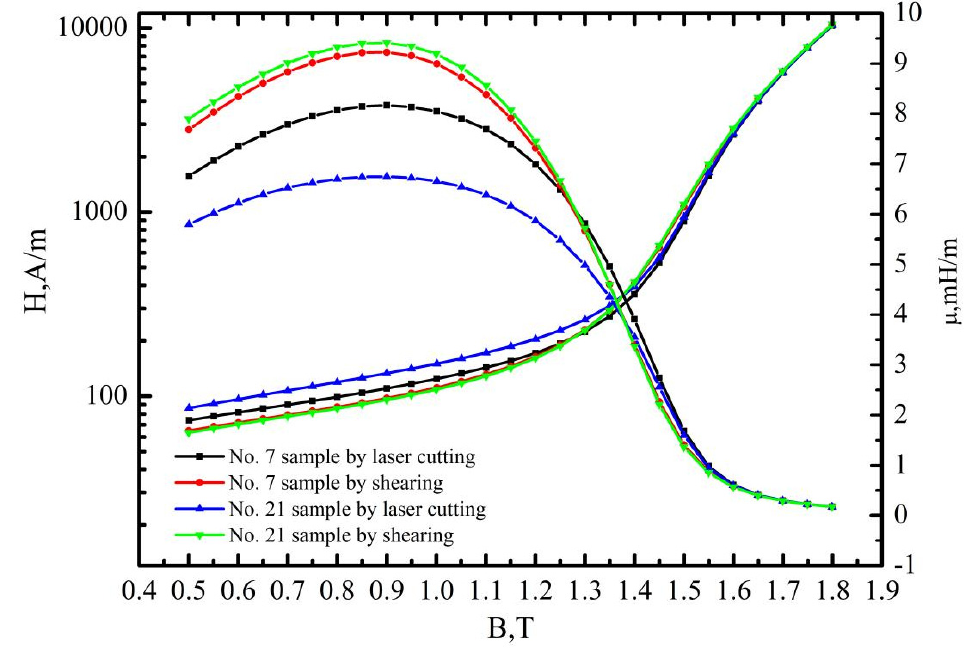
Figure 10. Magnetizing curve and permeability curve of the No. 7 and No. 21 samples processed using laser cutting and mechanic shearing, respectively.